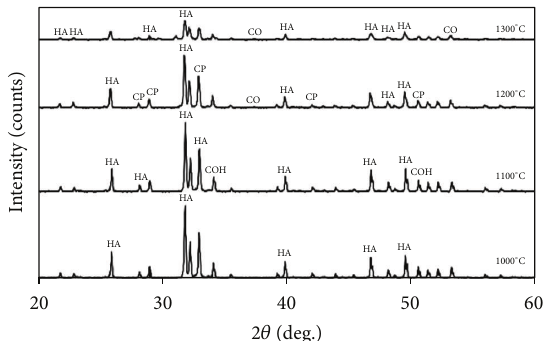
Figure 1: X-ray diffractograms of BHA samples sintered at different temperatures.